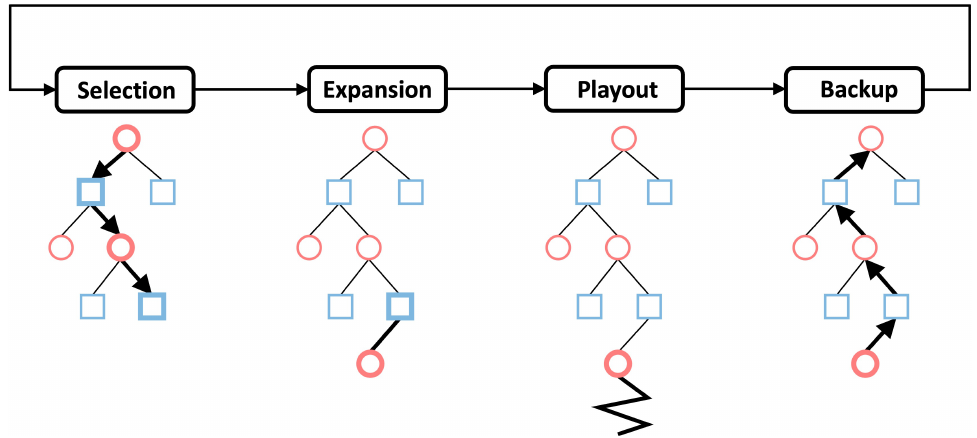
Figure 3. Illustration of